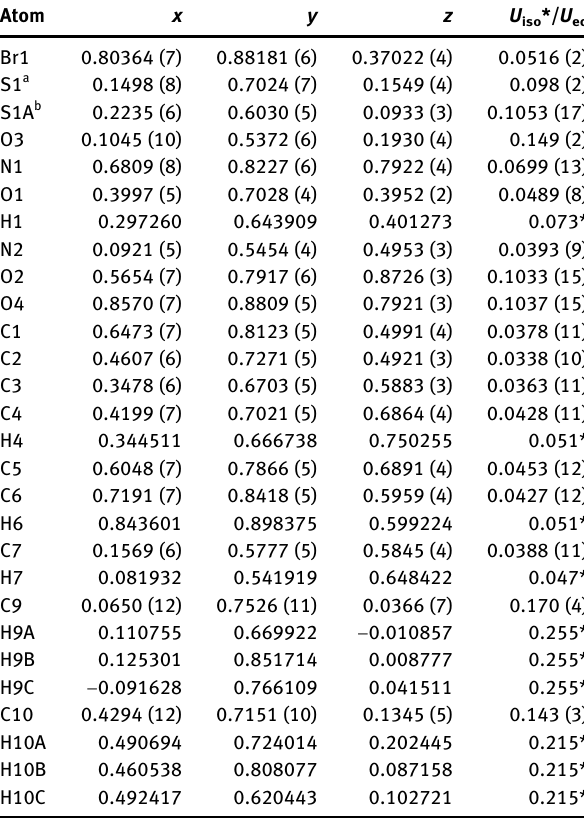
half of the hydrazine compound in the asymmetric unit. The aromatic carbon-carbon bond lengths deviate signi fi cantly, that the values of the C(3) – C(4) and C(1) – C(6) bond-